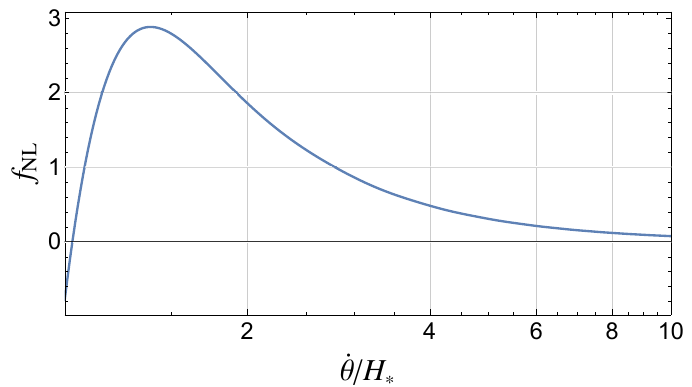
Figure 7 . The equilateral non-Gaussianity in the strong-mixing limit (cid:22) > H (cid:3) evaluated by the H -rescaling scheme for all exchange